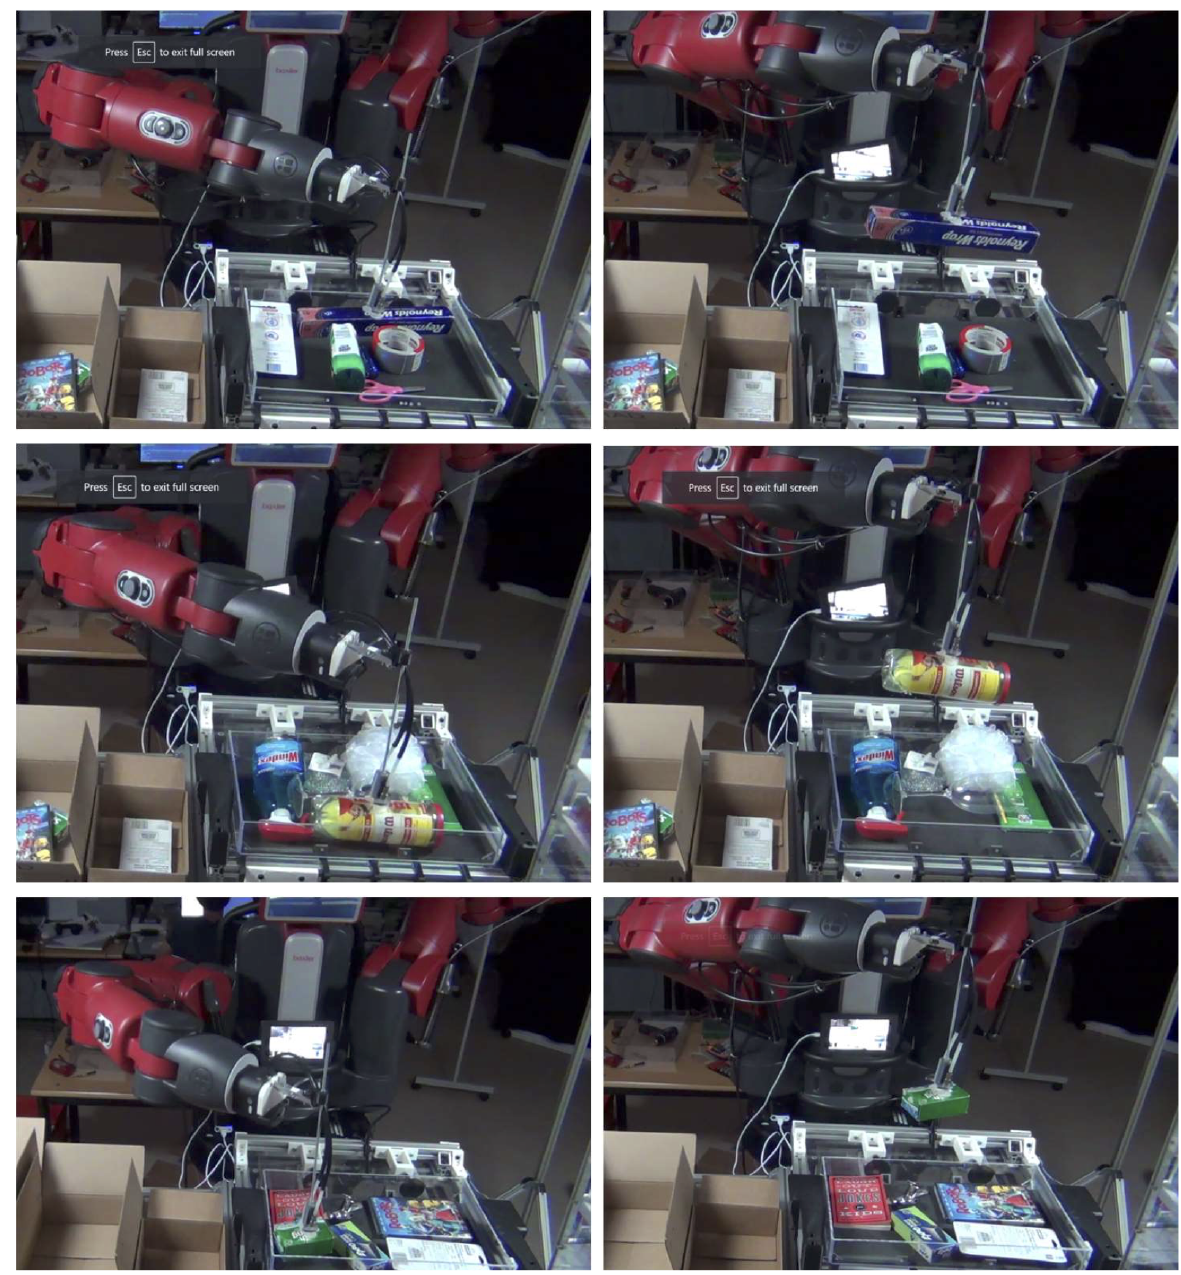
Figure 16. CNA with vacuum; successful grasp of the Reynold’s wrap, tennis ball container and Irish spring